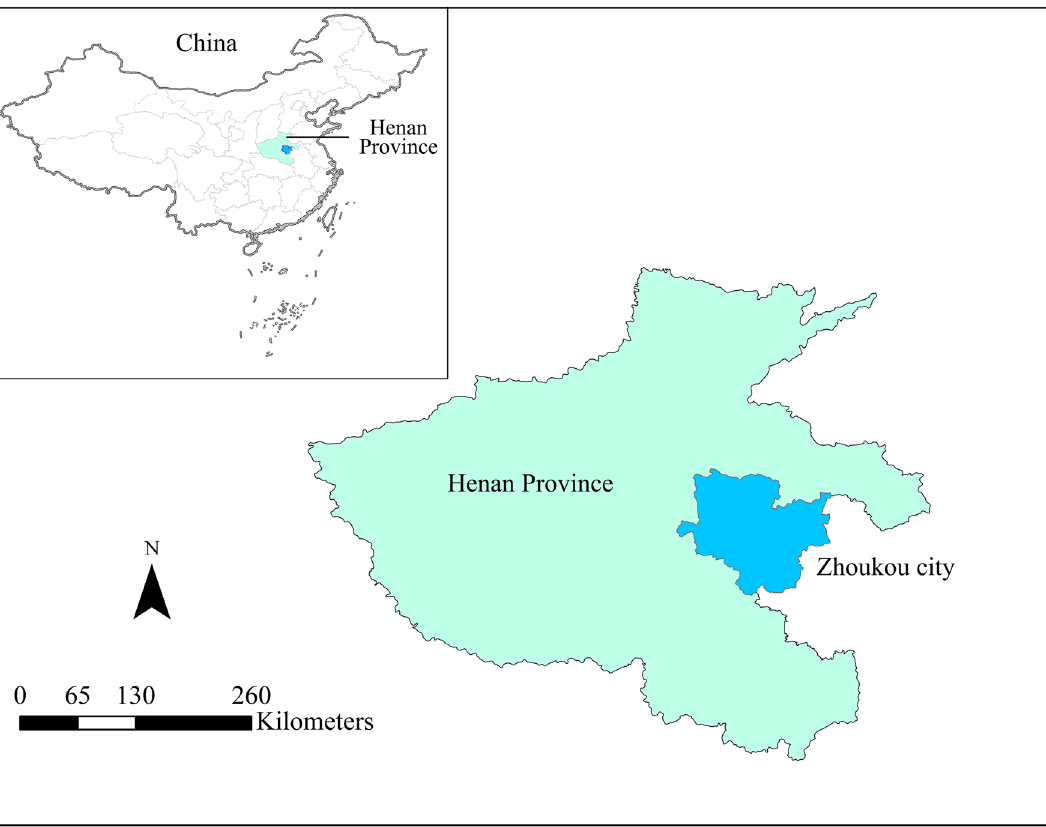
Figure 1. Geographical location of Zhoukou city of Henan province in China. We used the ArcGIS version 10.2 (ESRI, Redlands, CA, USA; https:// www. esri. com/) to create the